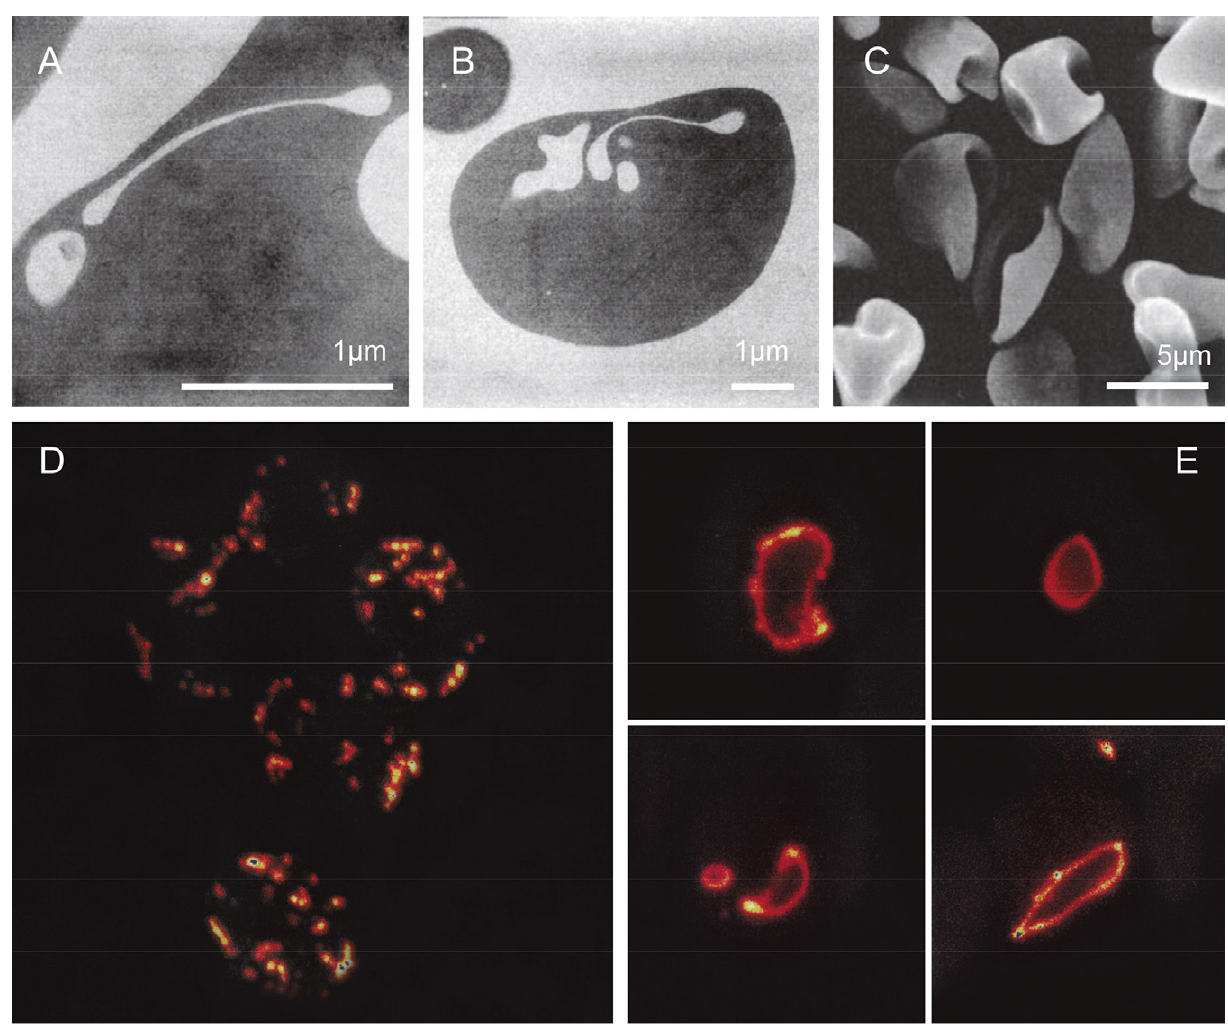
Figure 1: TEM and SEM micrographs showing stomatocytic human RBC with plate-like torocytic invaginations/endovesicles with a bulby periphery (panels A and B) formed in a process in which initially stomatocytic RBC invaginations (panel C) loose volume while maintaining a large surface area. RBCs were incubated by amphiphilic molecules octaethyleneglycol dodecylether (C 12 E 8 ). Panels D and E show confocal laser scanning micros- copy of RBCs incubated with amphiphilic molecules chlorpromazine inducing small spherical endovesicles (panel D) and with C 12 E 8 inducing toroidal endovesicles (panel E) as presented also in panels A and B. Adapted from.